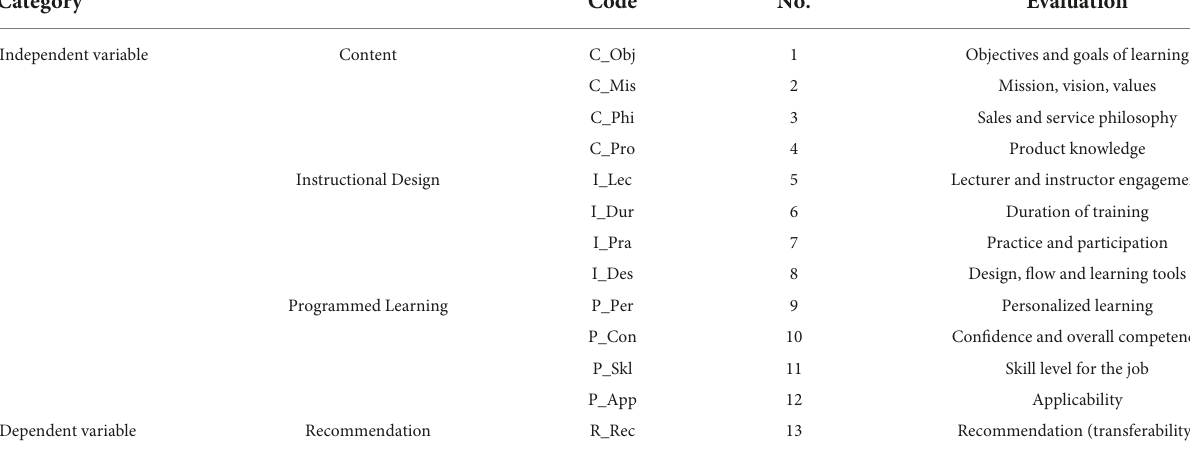
TABLE 1 Measurements.